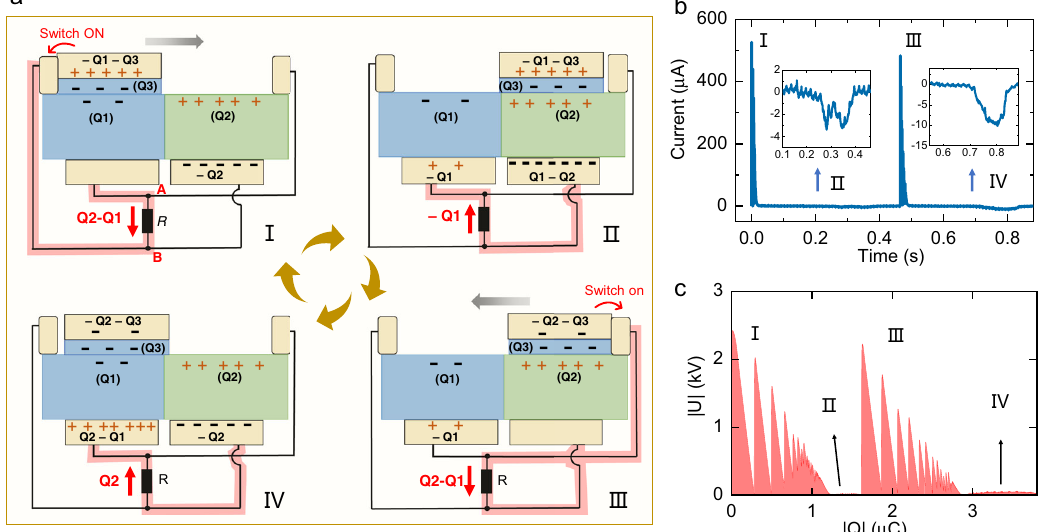
Fig. 2 Working principle of the OCT-TENG. a Schematic diagram of the working principle of the OCT-TENG. The charge transfer path in each stage is labeled in red. b The generated current and c U – Q plot of the OCT-TENG during one cycle of operation (load resistance of 4.7 M Ω